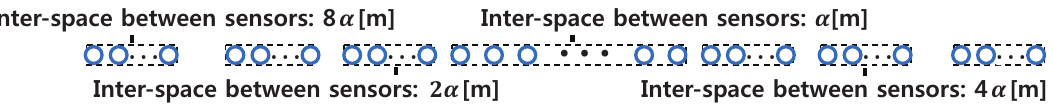
Figure 11. Structure of the horizontal nested sensor array.